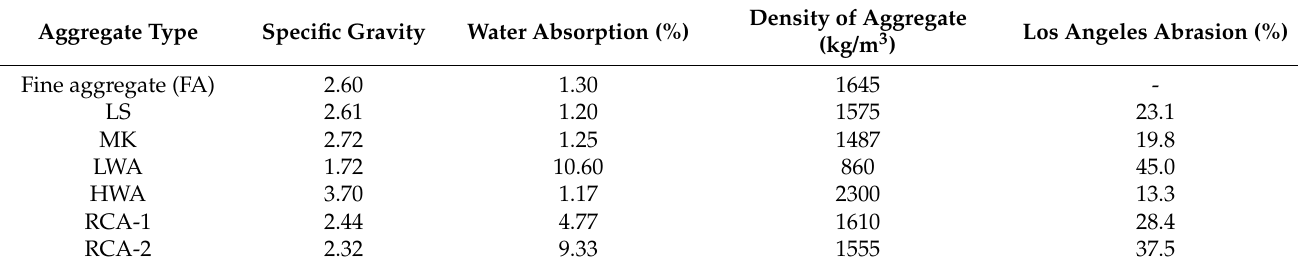
Table 1. Fine and coarse aggregates physical and abrasion properties.